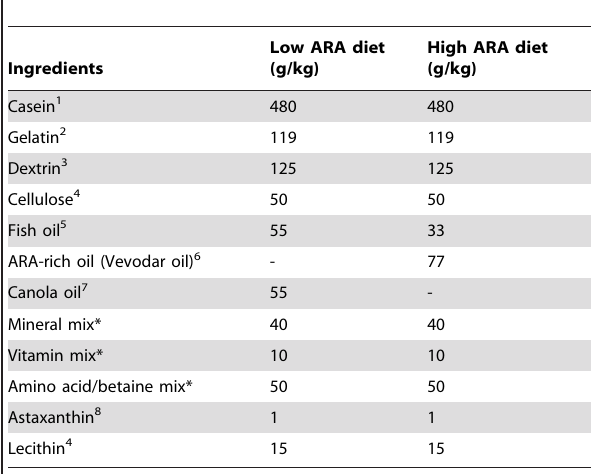
Table 1. Zebrafish feed